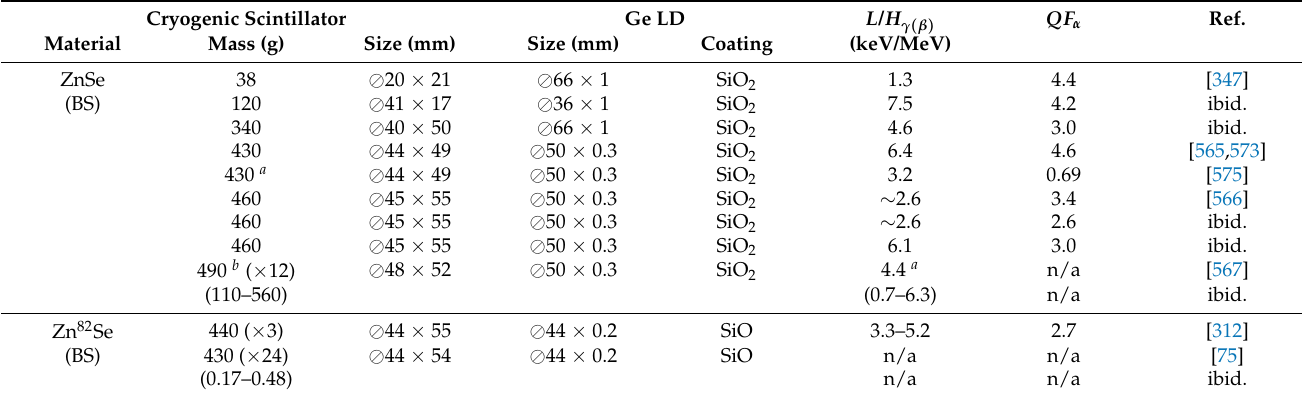
Table 8. Results of low-temperature scintillation detection with scintillating bolometers based on natural/ 82 Se-enriched ZnSe crystals and thin Ge LDs. The crystal growth method, the mass (two significant digits) and the size of the sample, the size and the coating of the coupled LD, as well as the L / H γ ( β ) and QF α values are